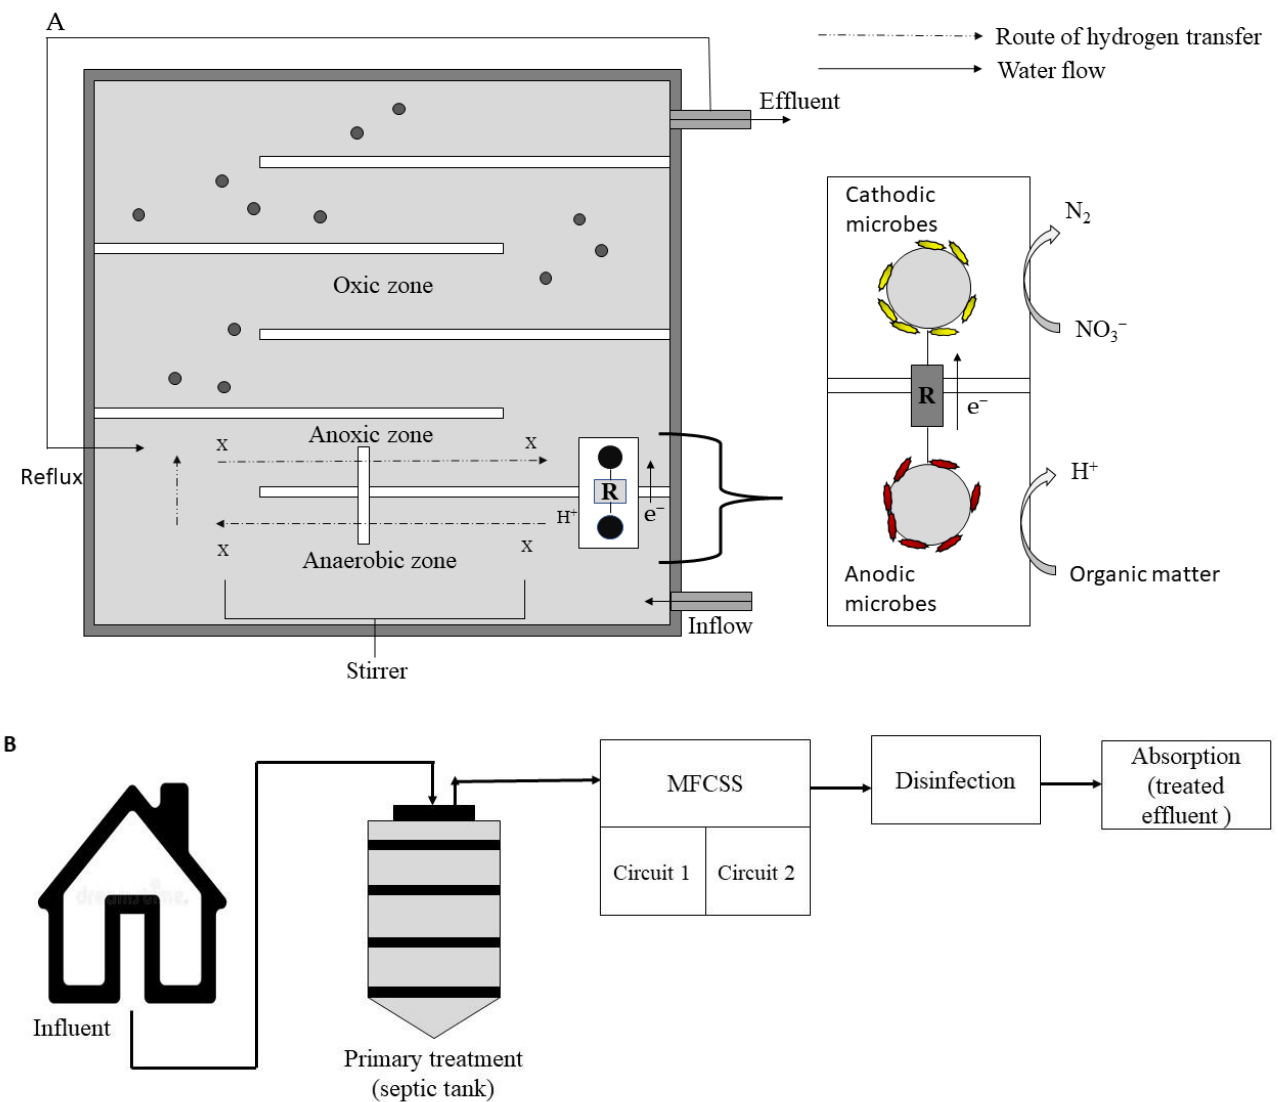
Figure 8. ( A ) Integrated MFC-AA/O system for wastewater treatment; ( B ) integrated MFC septic tank for wastewater